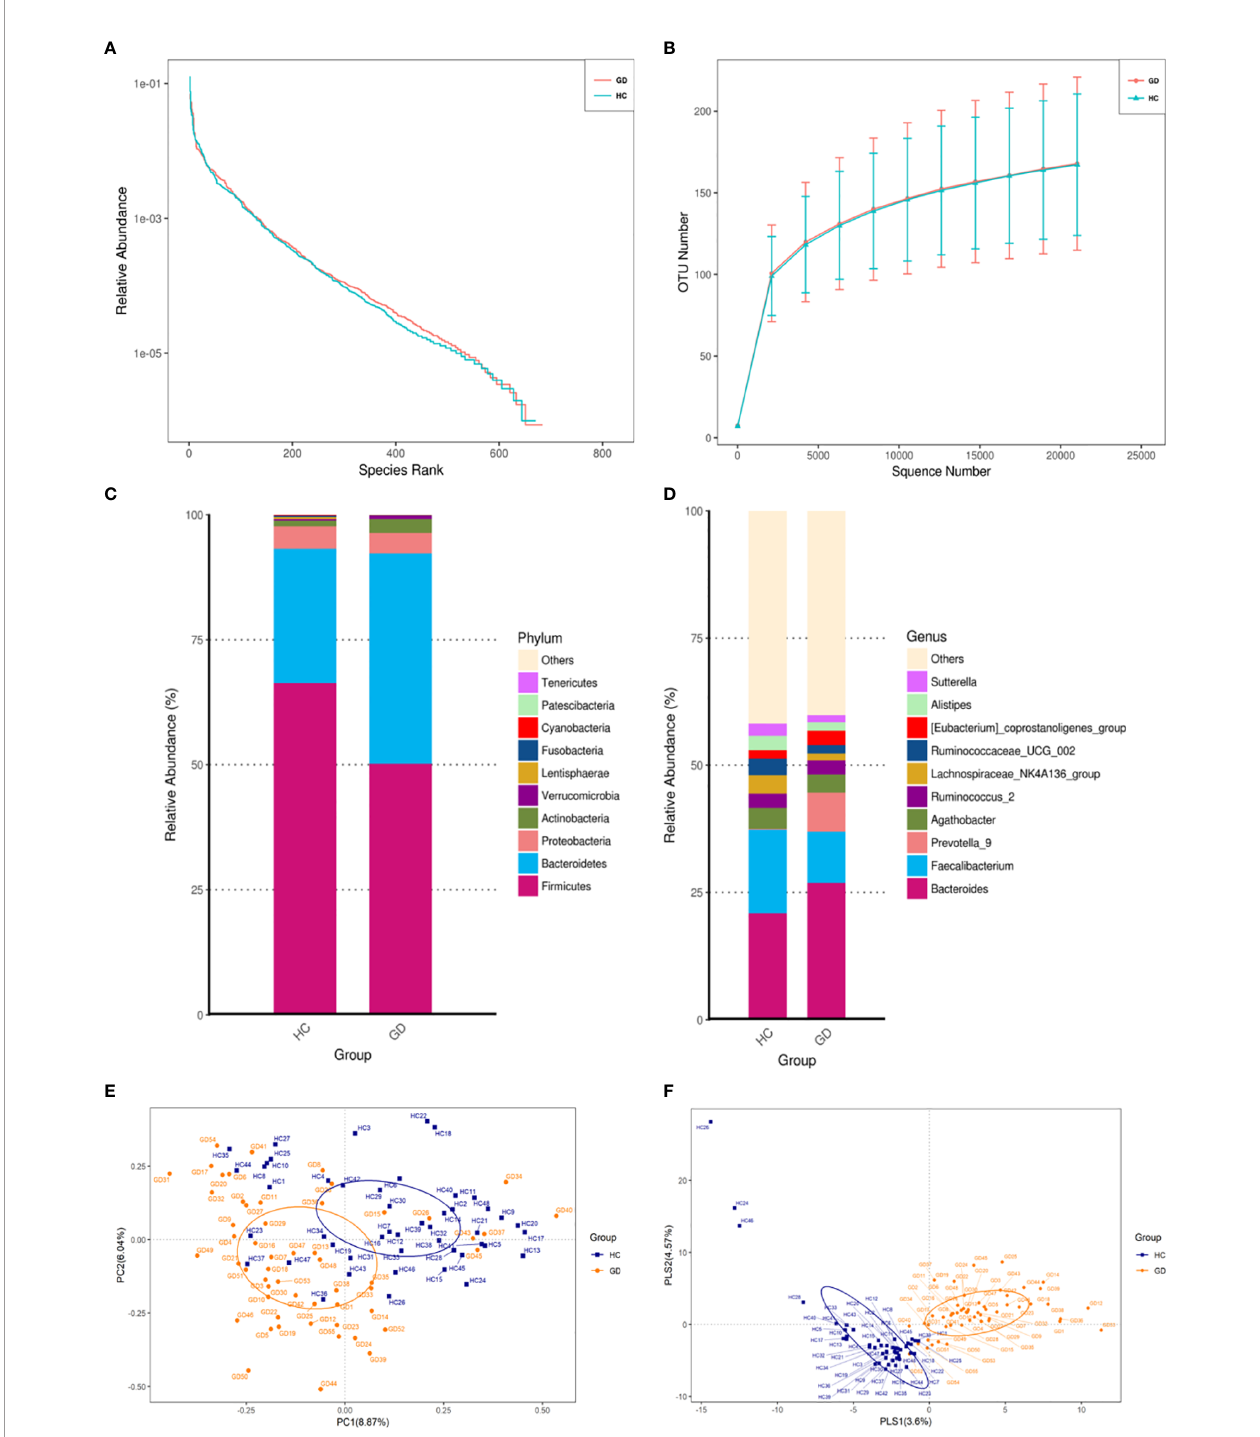
FIGURE 1 | The gut microbiota of GD patients differs from that of healthy controls. Rank-abundance curves were used to explain species richness and evenness (A) . Rarefaction curves were used to evaluate the species richness. The bacterial communities of the healthy controls (HC) and GD patients exhibited similar patterns (B) . The relative abundances of the top 10 microbial phyla and genera are represented. Only phyla and genera present at relative abundances >1% are shown. Taxa with lower abundances are grouped as “ other ” (C, D) . Principal coordinates analysis (PCOA) based on the distance matrix of Bray-Curtis dissimilarity at the OTU level showed that the gut microbiota of GD patients was separated clearly from those of healthy controls (E) . The PLS-DA (Partial Least Squares Discriminant Analysis) showed a signi fi cant separation between GD and healthy controls (F)